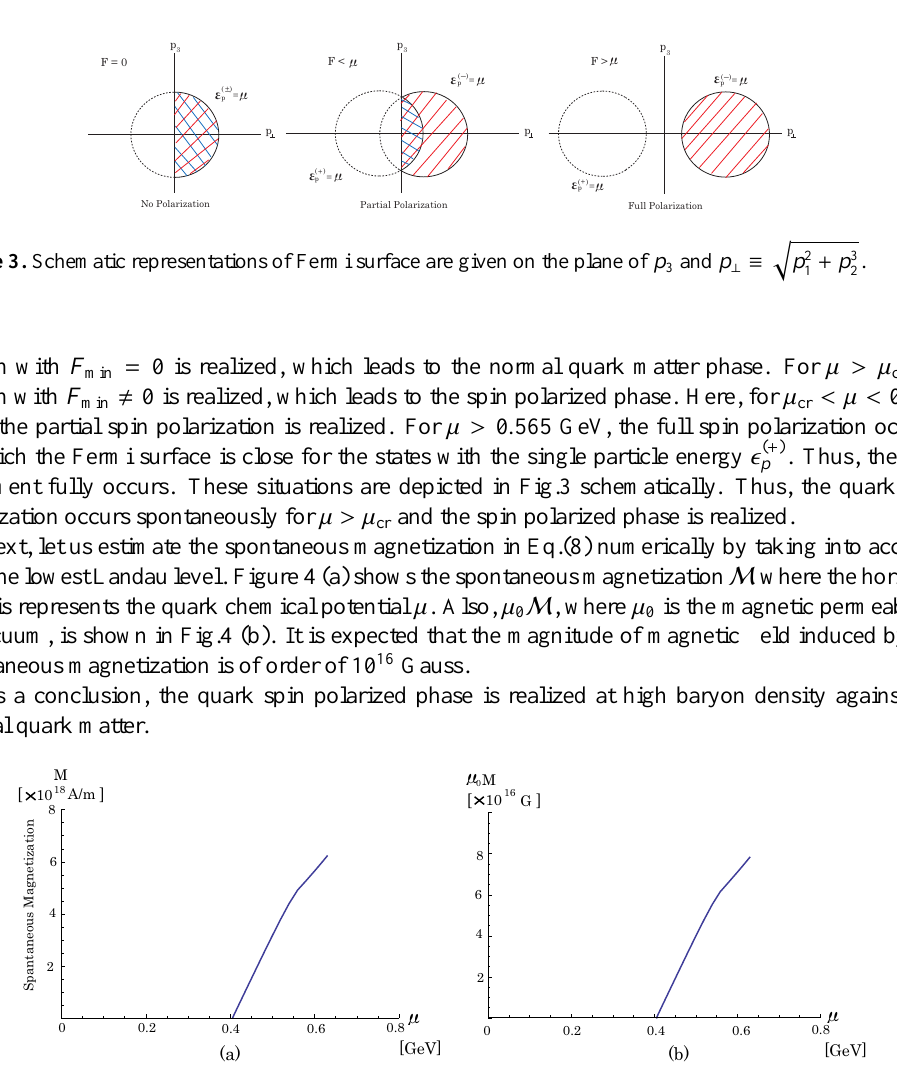
Figure 3. Schematic representations of Fermi surface are given on the plane of p 3 and p ⊥ ≡